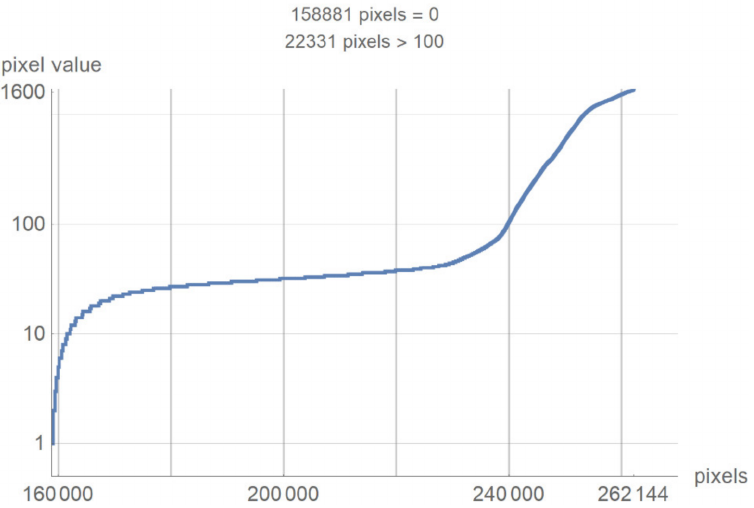
Figure 4. The number of pixels as a function of